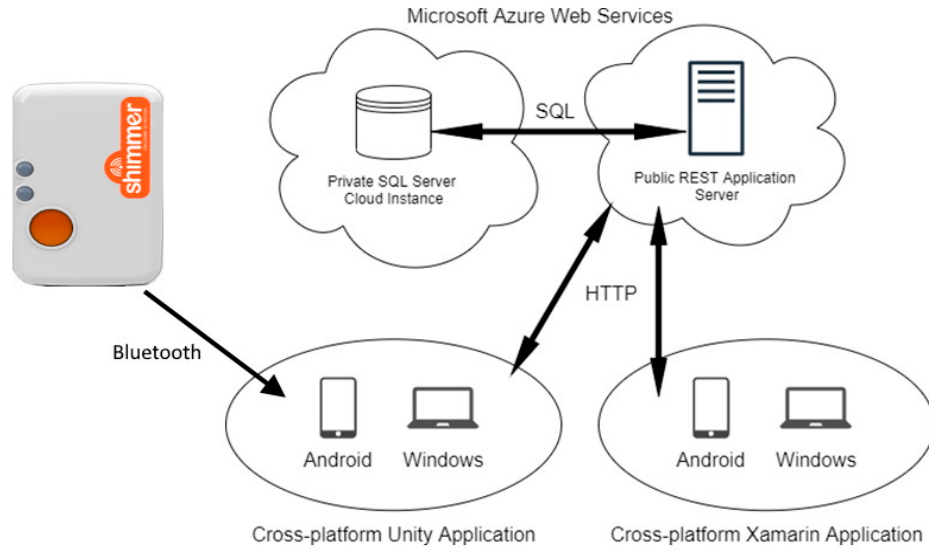
Figure 1. Program architecture and data flow .